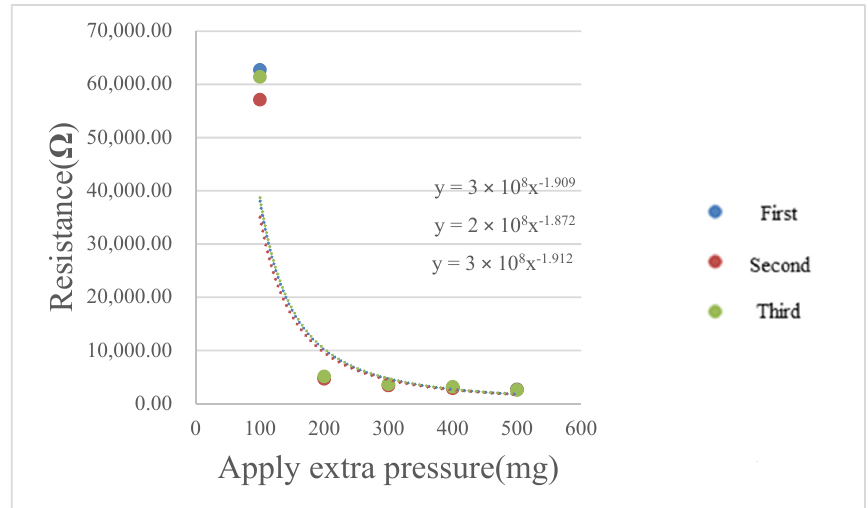
Figure 14. Micro pressure sensor correction curve diagram.